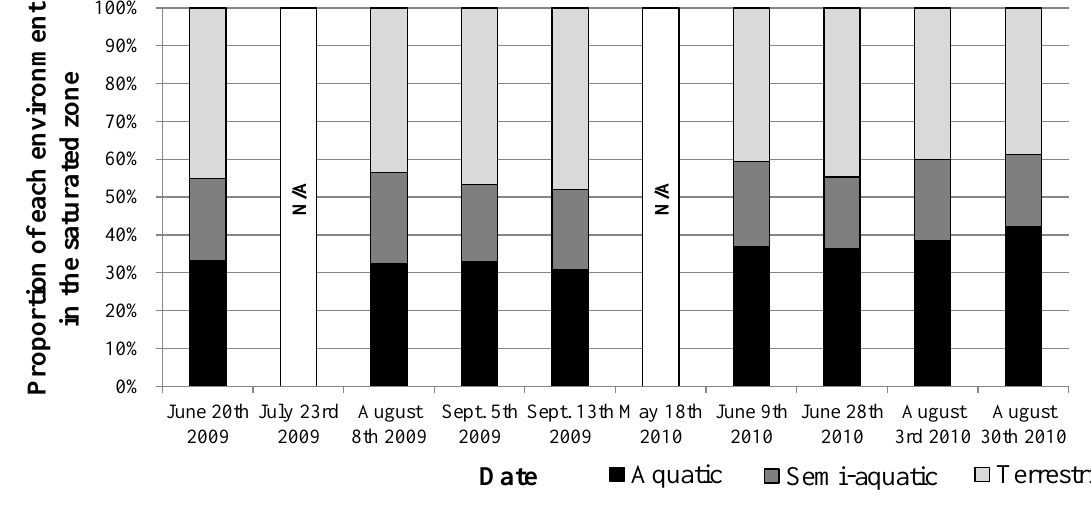
Figure 9. Aquatic, semi-aquatic, and terrestrial proportions of the site 2 saturated zone for each GeoEye-1 image acquisition date. The term N/A refers to missing data due to the presence of clouds over site 2.